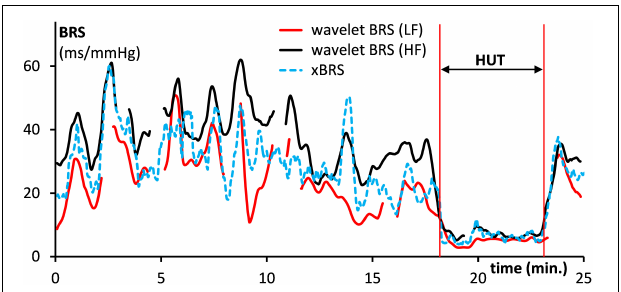
FIGURE 4 | Comparison of the computed xBRS (dotted line) with the wavelet BRS in the LF range (drawn red line) and the HF range (black). Data are for the subject of Figure 2 . The HUT period is